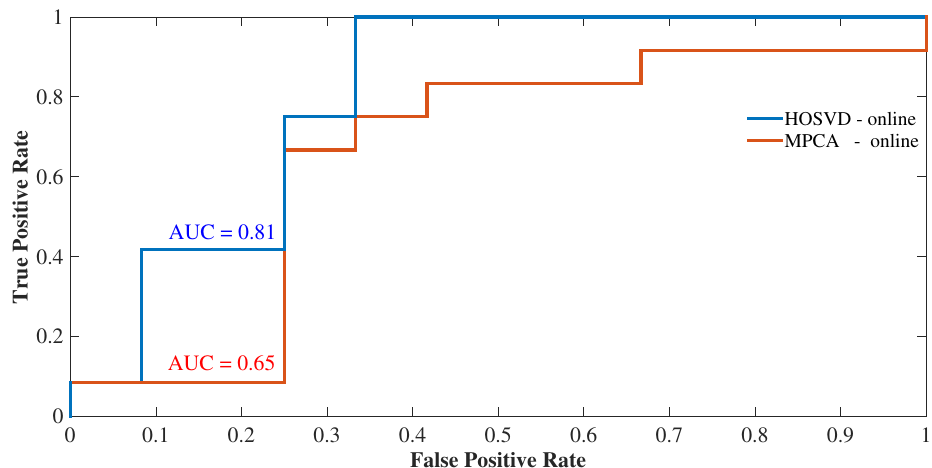
Figure 8. Detection performances of the methods, HOSVD online and MPCA